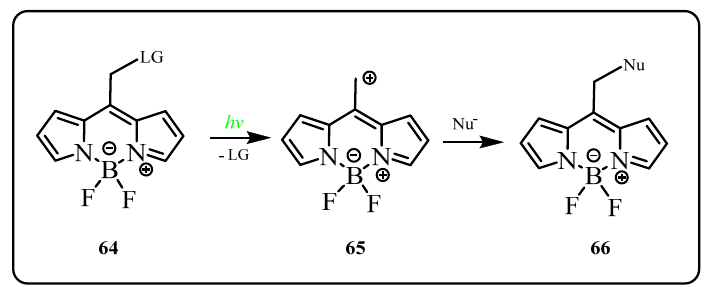
Scheme 8. Photochemical S N 1 reaction, the cleavage mechanism of BODIPYs.